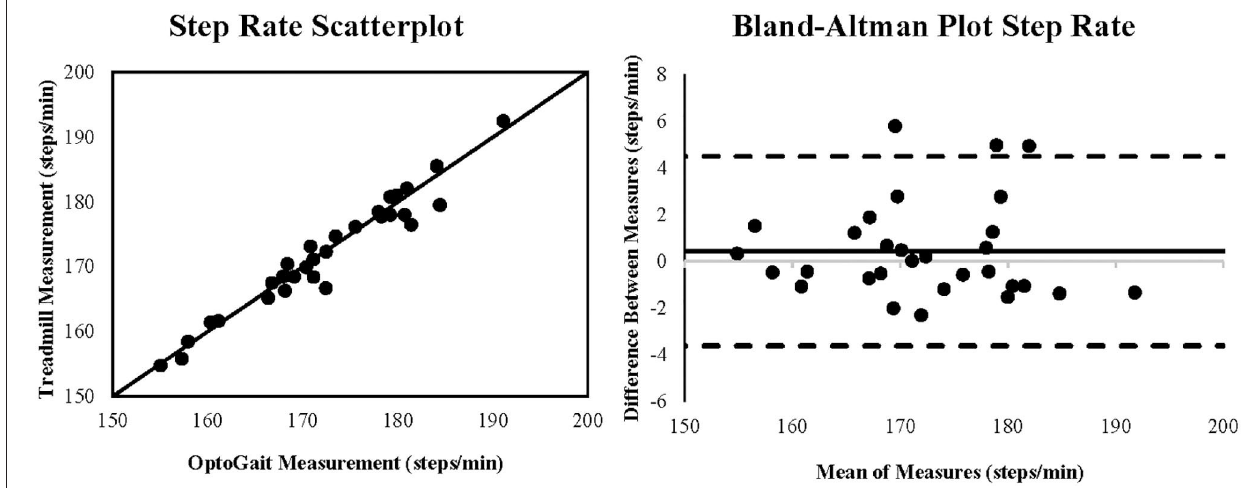
FIGURE 1 | Scatterplot and Bland-Altman plot for the measurement of step rate (steps/minute) during running for the OptoGait vs. instrumented treadmill. The Bland-Altman plot includes the bias (solid black line) and the upper and lower 95% limits of agreement (dashed lines).